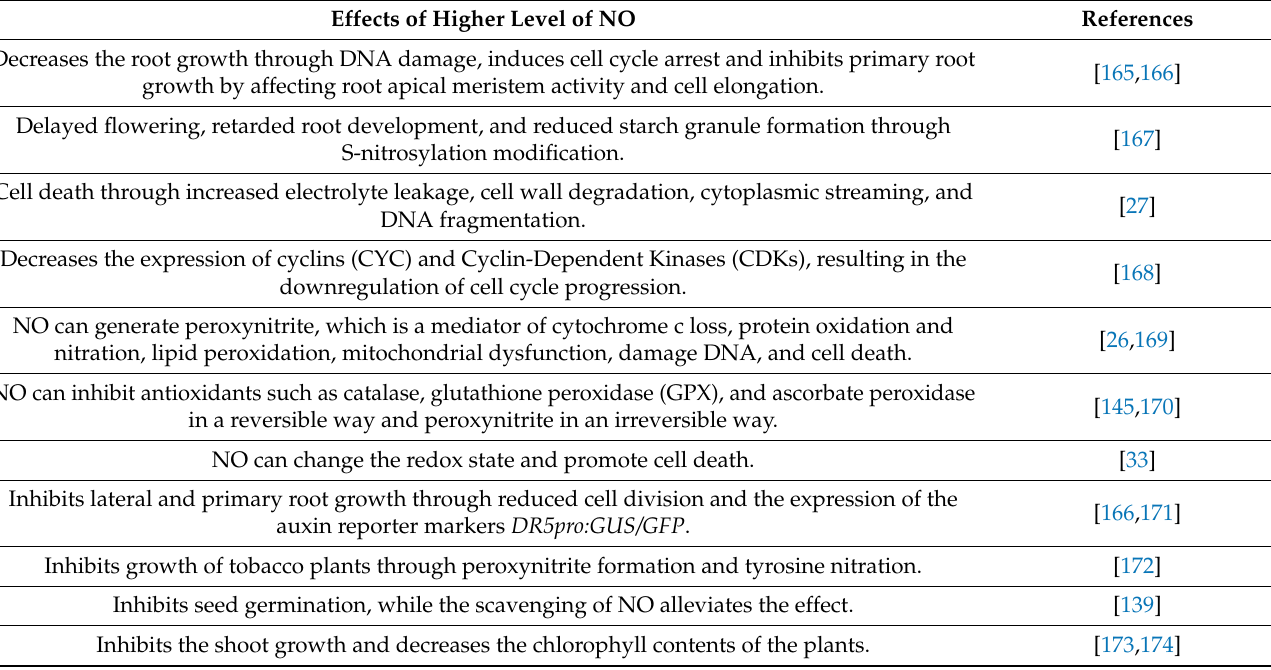
Table 2. Adverse effects of a higher level of NO in plants. The high level of NO was achieved through a higher dose of NO donor or using NO-overproducing mutants or hypoxia plus NO donors. Effects of Higher Level of